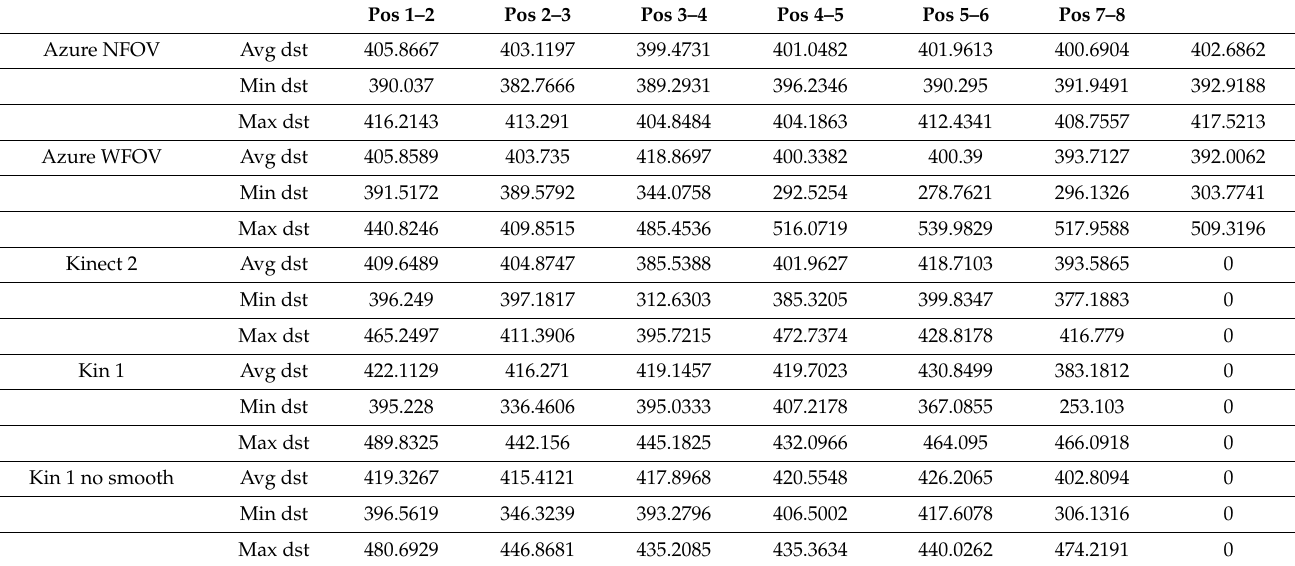
Table 3. Key data for all positions and sensors.